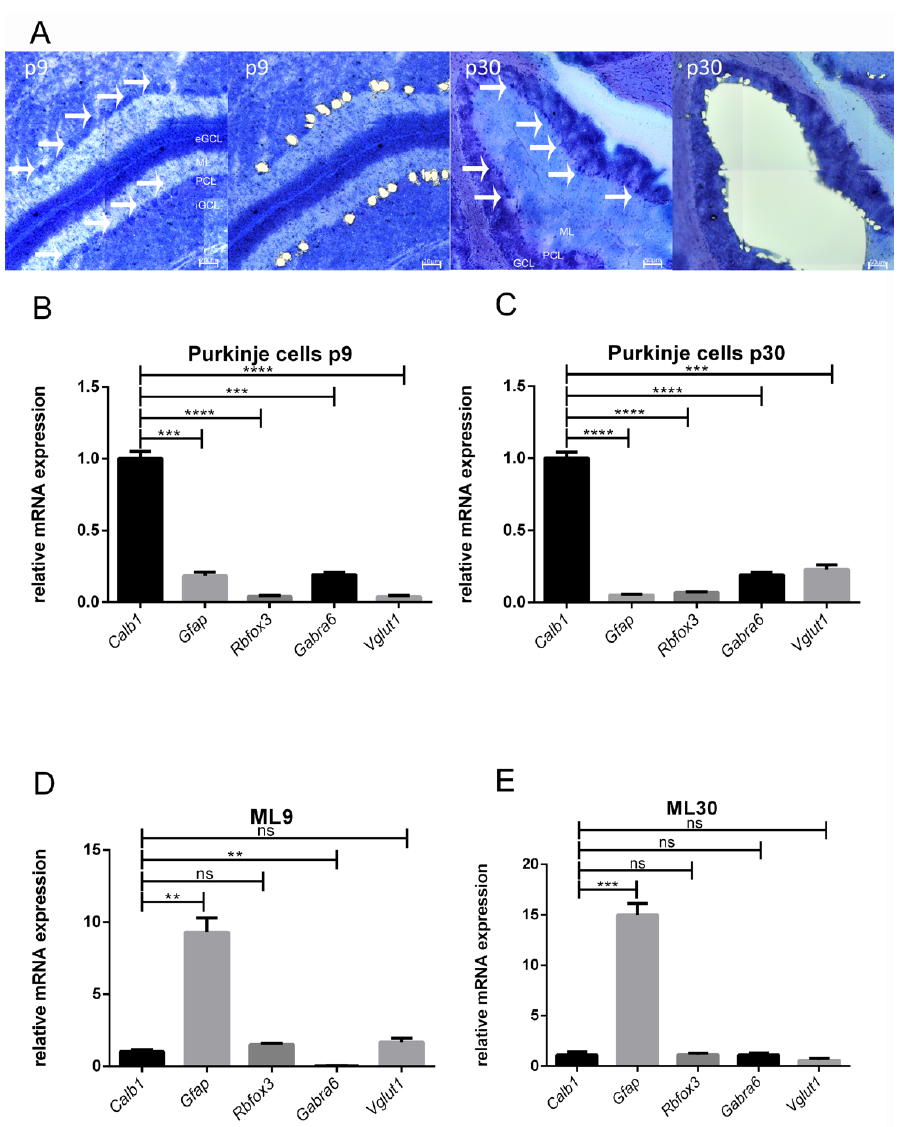
Figure 1. Accuracy of LMD: Laser microdissection of PCs at the age of p9 and p30 ( A ). Methylene blue-stained cryosections (12 µm) from rat cerebella. Cerebellar layers are marked as external granular cell layer (eGCL), molecular layer (ML), internal granular cell layer (iGCL) and Purkinje cell layer (PCL). White arrows indicate PCs. Scale bar: p9 = 20 µm, p30 = 50 µm ( B , C ) The mRNA of microdissected PCs of p9 and p30 showed high Calb1 and low Gfap levels indicating only a slight contamination with glial cells. ( D , E ) In the microdissected molecular layer, a high expres- sion of Gfap relative to markers for neurons except PCs was detected. In all four samples, the markers were normalized against Calb1 and Gapdh was used as housekeeping gene. Note that 1,000,000 µm 2 of enriched PCs and 1,000,000 µm 2 of the ML from 20 different rat cerebella were collected. Significant differences were indicated by ** p < 0.01, *** p < 0.001, **** p < 0.0001; ns = not significant. 3.2. PC Culture and VEGF Receptor Expression To further visualise the PC culture, we performed immunostaining with an antibody against calbindin, particularly concentrated in the dendrites and perikarya of cerebellar PCs (Figure 2A). With the help of a phase-contrast microscope, cultures were analysed in